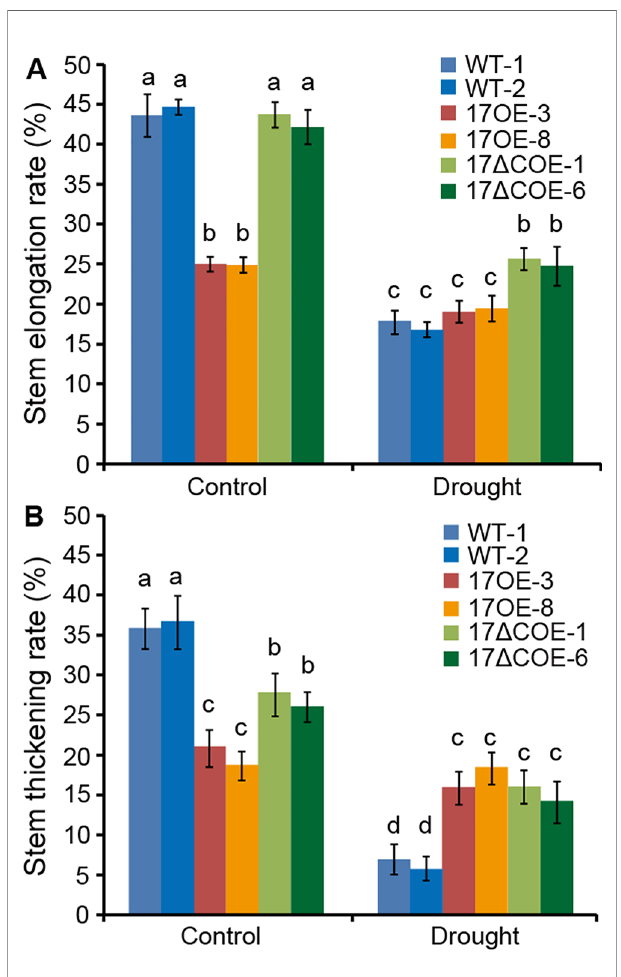
FIGURE 7 | Stem elongation and thickening rates of 3-month-old WT, Pd C3H17OE (17OE), and Pd C3H17 D COE (17 D COE) poplars after well- watered or drought stress conditions for 20 days. (A) Stem elongation rate. (B) Stem thickening rate. At least six plants of two lines in each genotype were measured. Data are presented as mean ± Different letters above bars denote statistical signi fi cance between treatments of samples ( P <